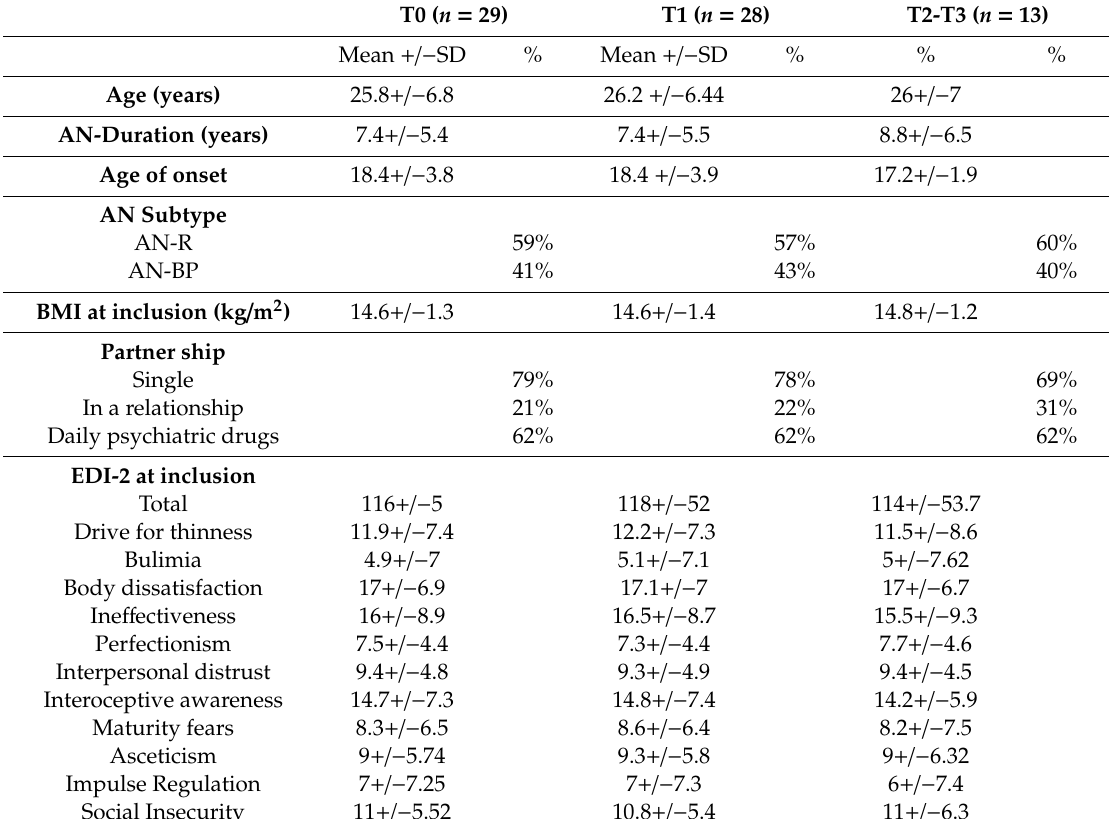
Table 1. Demographic, anthropometric and socio-economic characteristics of anorexia nervosa in the clinical samples. Data are presented as mean +/ − SD. T0: at admission; T1: 50–70% of target BMI reached; T2-T3: weight recovered patients with evaluation one month post discharge; AN: